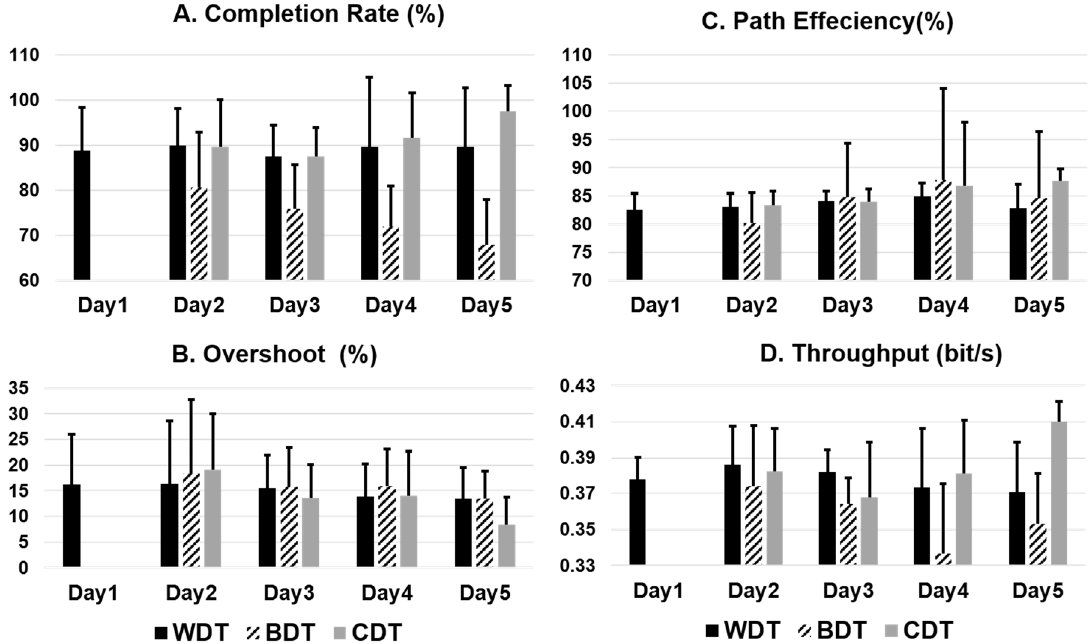
Sensors 2020 , 20 , x FOR PEER REVIEW Figure 5. Comparison of real-time performance parameters over five days for all three testing schemes. Table 5. Session wise difference in all three control schemes. Results depict averaged performance over five days per session. Asterisks (*) indicate a case where there is a significant difference.